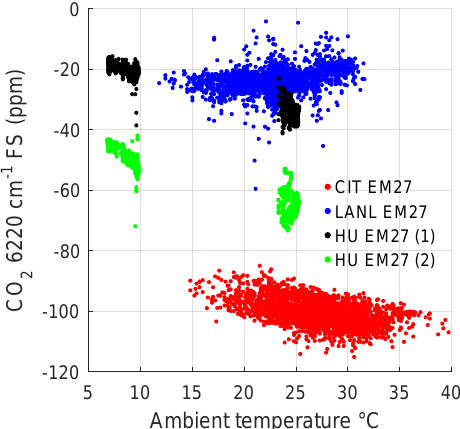
Figure 2. Frequency shifts (FS) of all four instruments vary with temperature because the lasers are not frequency-stabilized. FS for the CO 2 6220cm − 1 window are shown. FS of the Caltech (CIT) instrument are far from zero, so an empirical correction is made to correct the sample spacing number. Only every 300th CIT point and every 20th LANL point is plotted for clarity. HU EM27 1 and 2 are also referred to as ha and hb respectively by Chen et al.